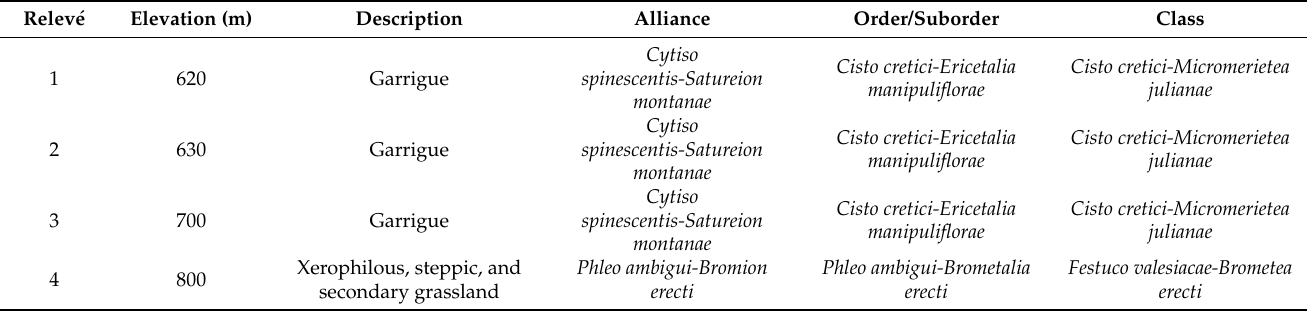
Table 1. Description of the investigated communities. For each relev é , the vegetation type is briefly indicated and its syntaxonomic classification at the level of alliance is given, as established by Pirone [72], with nomenclature and higher classification updated according to Prodromo della vegetazione d’Italia